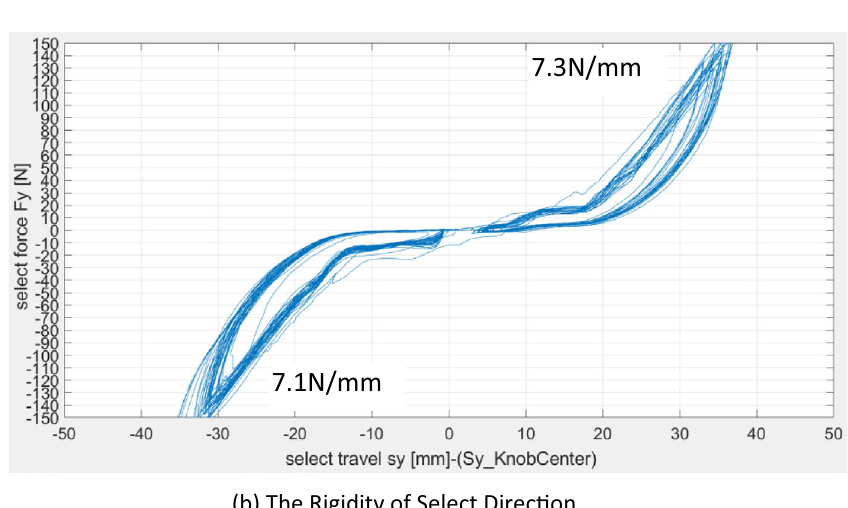
Figure 9. The actual shift and selected